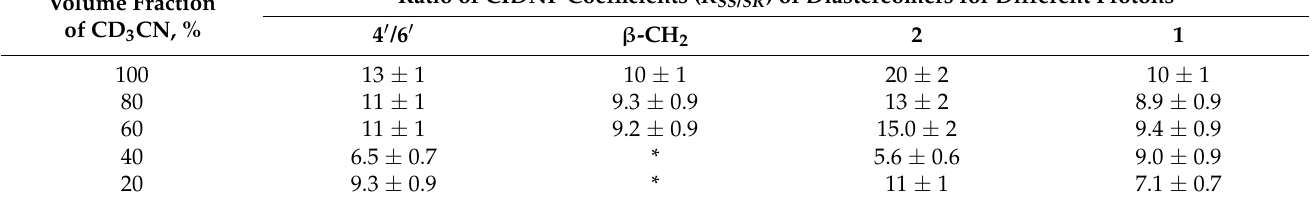
Table 3. Spin selectivity of protons in diastereomers of dyad III detected in solvent with different dielectric constants (mixtures of CD 3 CN/C 6 D 6